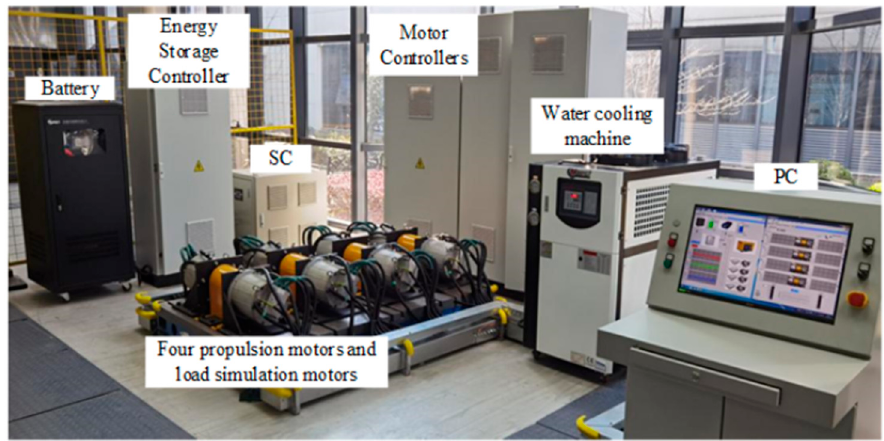
Figure 13. Experimental platform of DEPA.